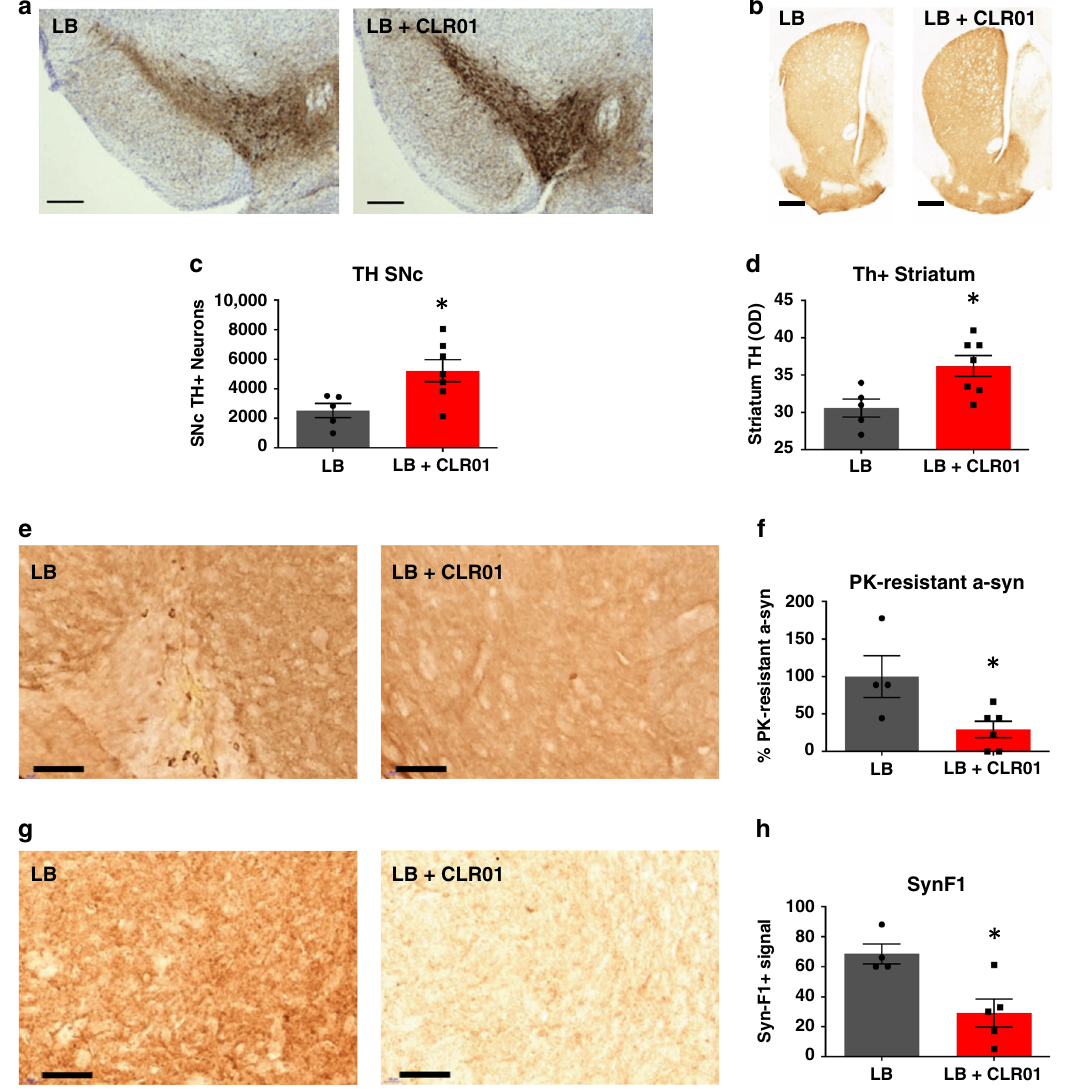
Fig. 6 CLR01 protects dopaminergic neurons from LB-induced cell death through reduction of α -syn aggregation in mice. a , b Representative photomicrographs of TH-immunostained SNc and striatum (respectively) in LB-inoculated mice after osmotic mini-pump implantation for CLR01 (or PBS) delivery (40 µ g/kg/h). c Stereological cell counts of SNc TH-immunoreactive neurons ( a ) in LB-inoculated mice, at 3 months post-LB inoculation. p = 0.0177. d Optical densitometry of striatal TH immunoreactivity in LB-inoculated mice ( b ), at 3 months post-LB inoculation. p = 0.0354. e , g Representative photomicrographs of α -syn and PK-resistant α -syn immunostained SN from LB-inoculated mice, and corresponding quanti fi cation. f , h Representative images of Syn-F1 immunostaining in the SN in LB-inoculated mice and corresponding quanti fi cation of the intensity levels of Syn-F1 staining. f p = 0.0333, h p = 0.0556. a – h n = 4 – 5 for LB-inoculated mice, n = 5 – 7 for LB + CLR01-independently treated animals, analyzed with a two-tailed Mann – Whitney U - test. * p < 0.05. Scale bars = 0.1 mm (SN) and 1 mm (Str). For all appropriate panels, data are presented as mean values ±